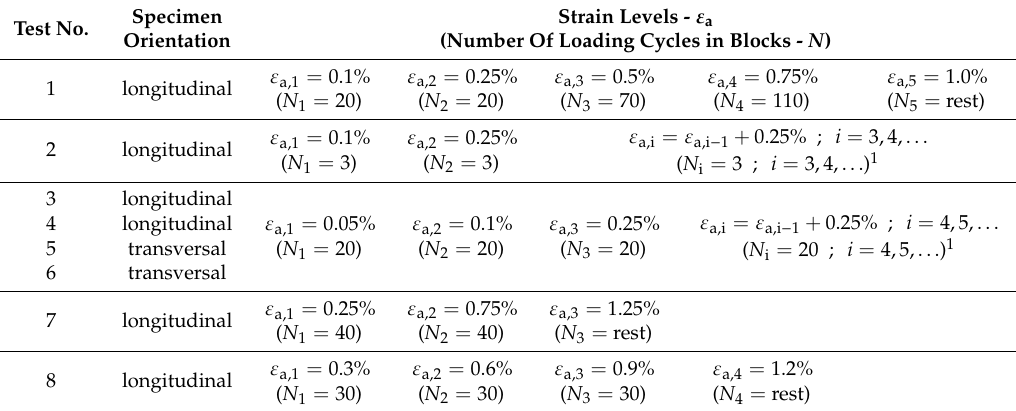
Table 1. Step-strain low-cycle fatigue experiments.